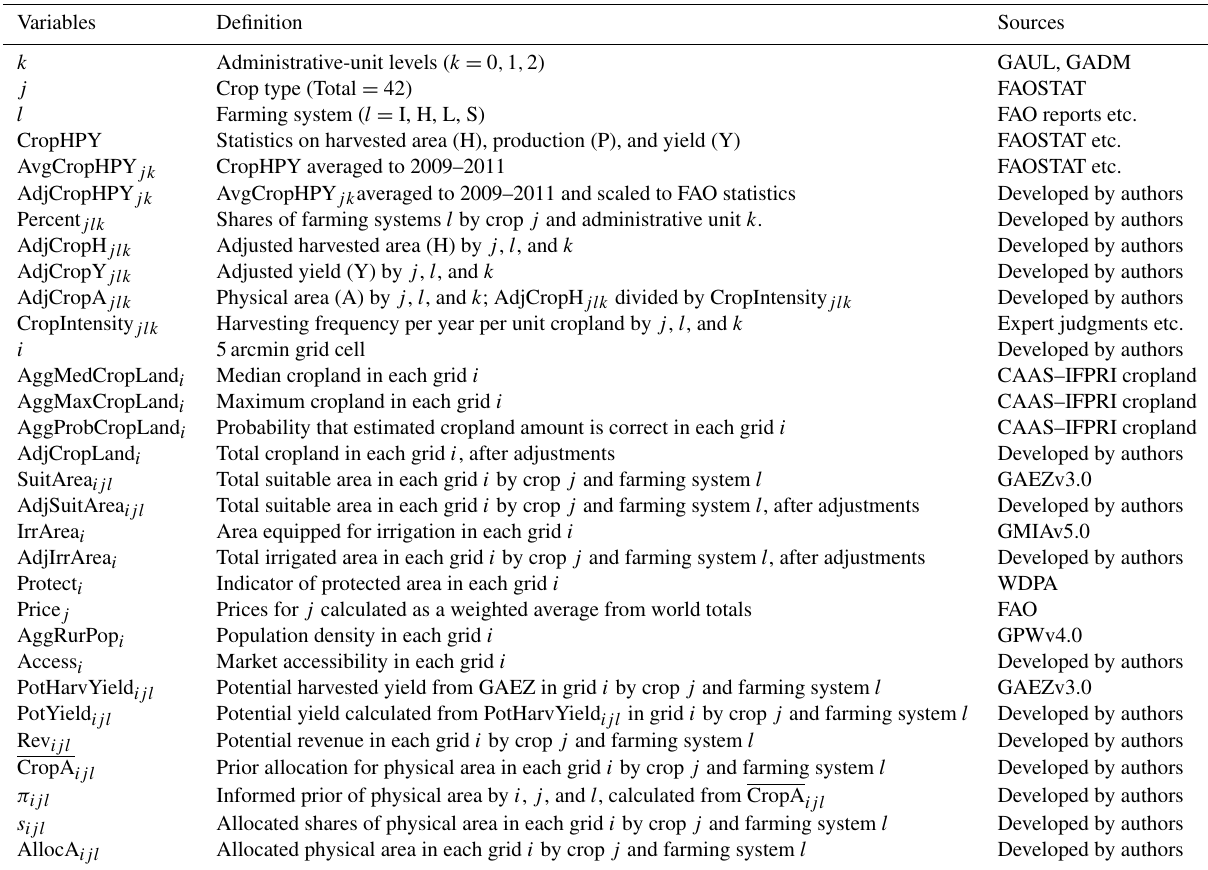
Table 2. The main input variables used in SPAM2010.